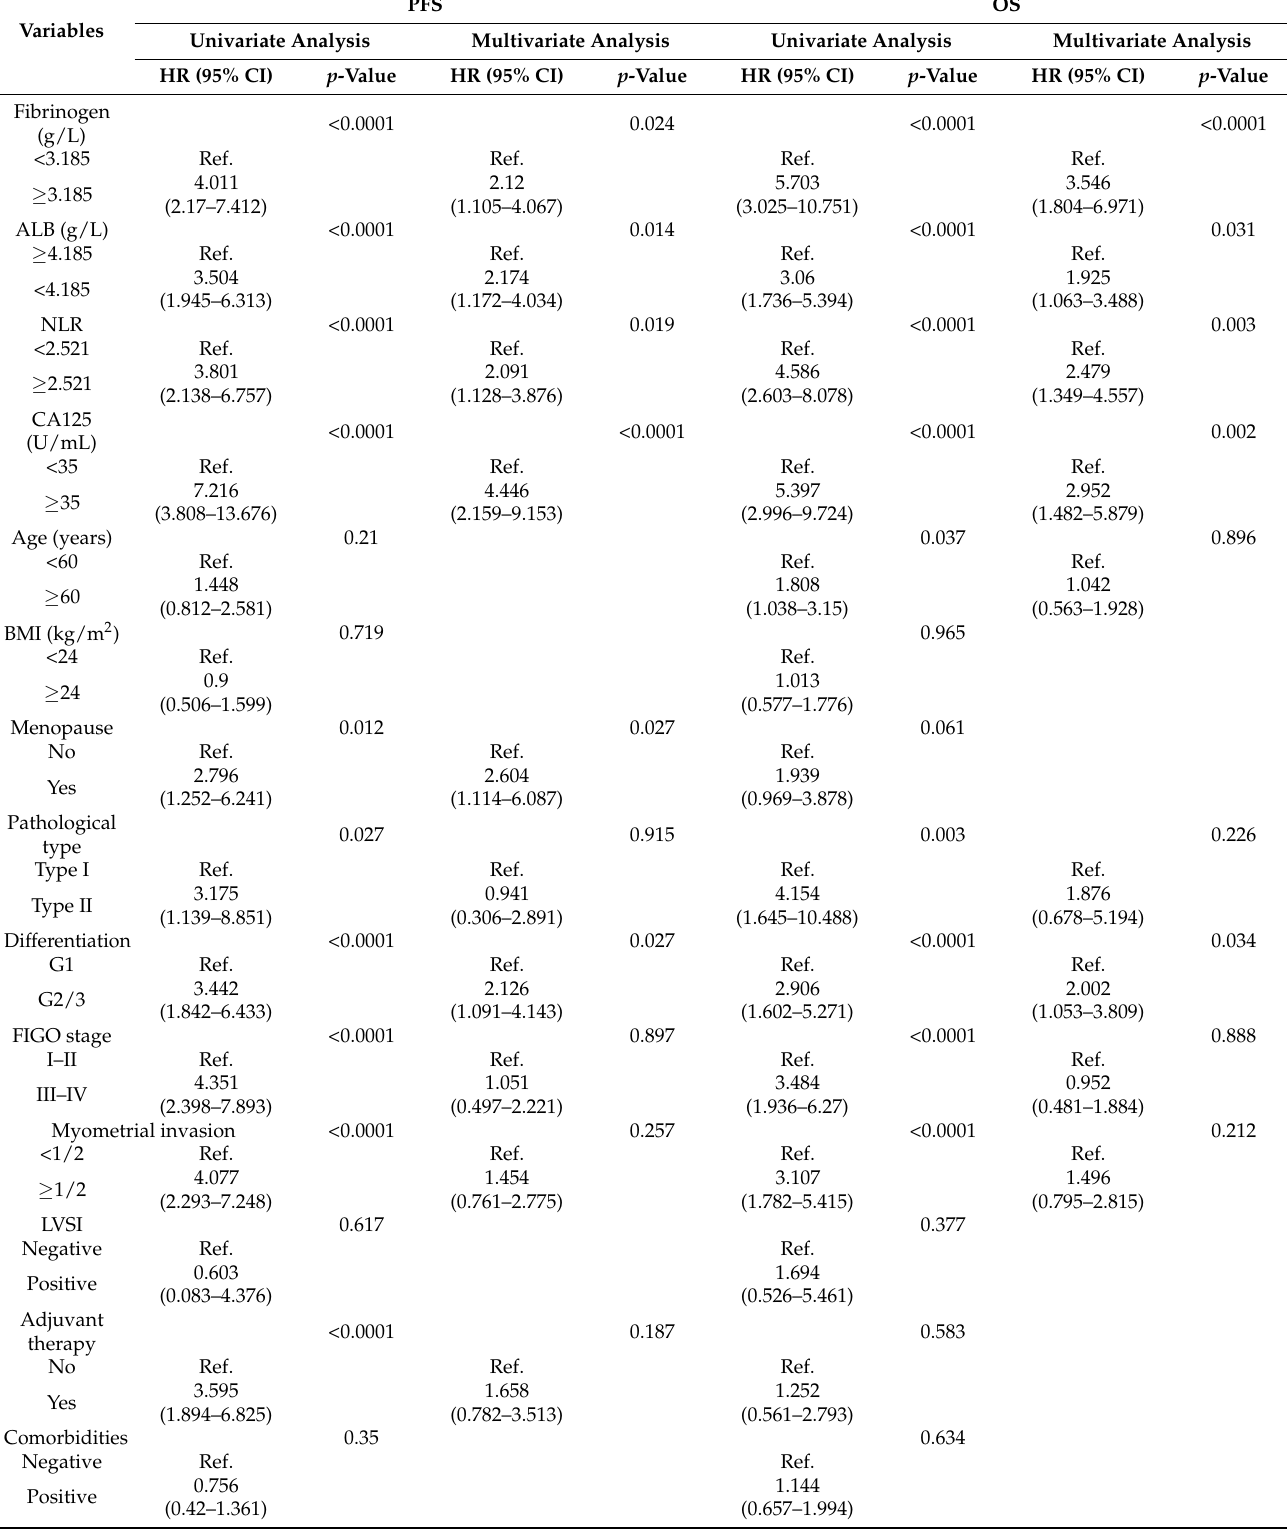
Table 2. Univariate analysis and multivariate analysis of PFS and